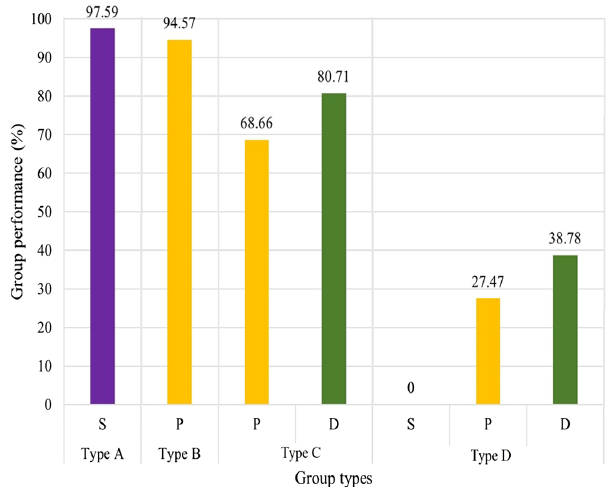
FIG. 3. Group performance according to a variety of group members ’ individual-round